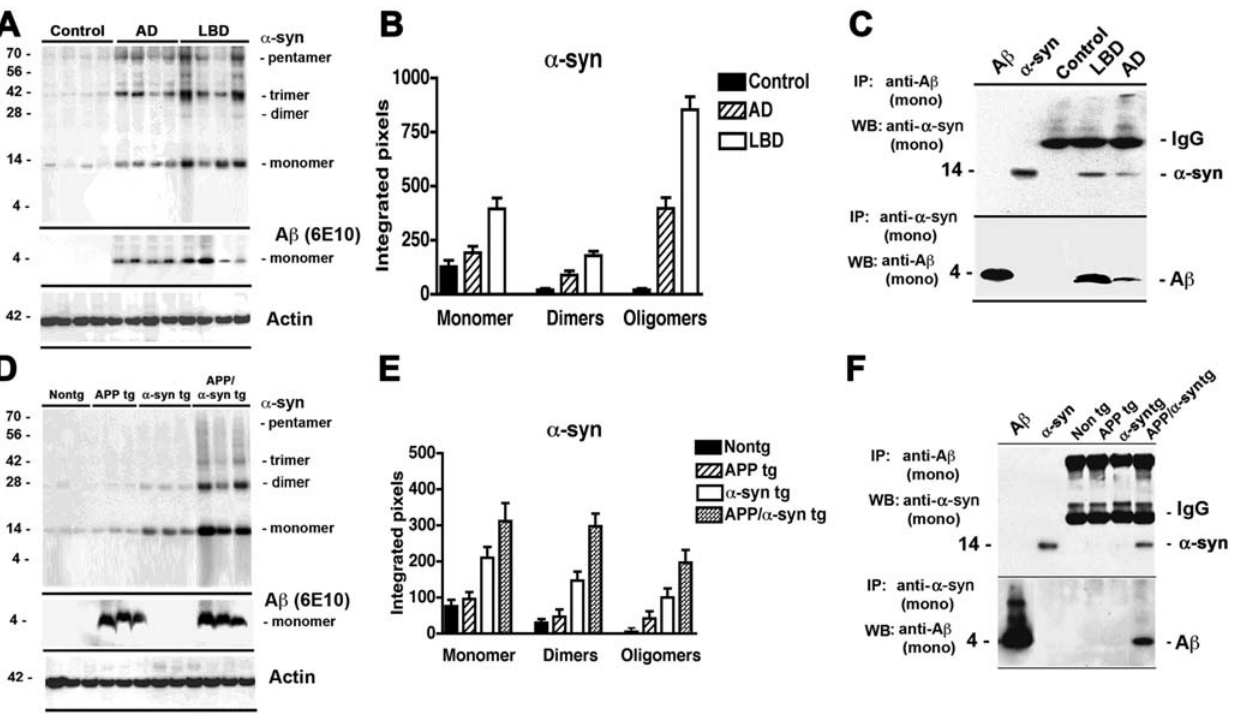
Figure 1. Immunoblot and co-immunoprecipitation analysis of aggregated a -syn in brains of LBD cases and tg mice. ( A, B ) Representative western blot ( A ) and semi-quantitative analysis ( B ) of levels of a -syn dimers and oligomers in membrane fractions from the frontal cortex of age-matched non-demented control, AD and LBD brains. In cases with LBD there was a significant increase in the levels of a -syn dimers and oligomers when compared to controls. ( C ) Immunoprecipitation of homogenates from control, LBD and AD cases with monoclonal antibodies against A b (upper panel) or a -syn (lower panel). Immunoblots were probed with monoclonal antibodies against a -syn (upper panel) or A b (lower panel). A b and a -syn pure proteins were included on the immunoblots as positive controls (first and second lanes). ( D, E ) Representative western blot ( D ) and semi-quantitative analysis ( E ) of levels of a -syn dimers and oligomers in the membrane fractions from nontg, APP tg, a -syn tg, and APP/ a -syn double tg brains. In APP/ a -syn tg mice there was a significant increase in the levels of a -syn dimers and oligomers when compared to nontg or single tg animals. ( F ) Immunoprecipitation of brain homogenates from nontg, APP tg, a -syn tg, and APP/ a -syn double tg animals with monoclonal antibodies against A b (upper panel) or a -syn (lower panel). Immunoblots were probed with monoclonal antibodies against a -syn (upper panel) or A b (lower panel). Bar graphs represent the mean of n=4 cases per group. *P , 0.05 compared to control human brains or nontg mouse brains (by one- way ANOVA with post-hoc Tukey-Kramer test).